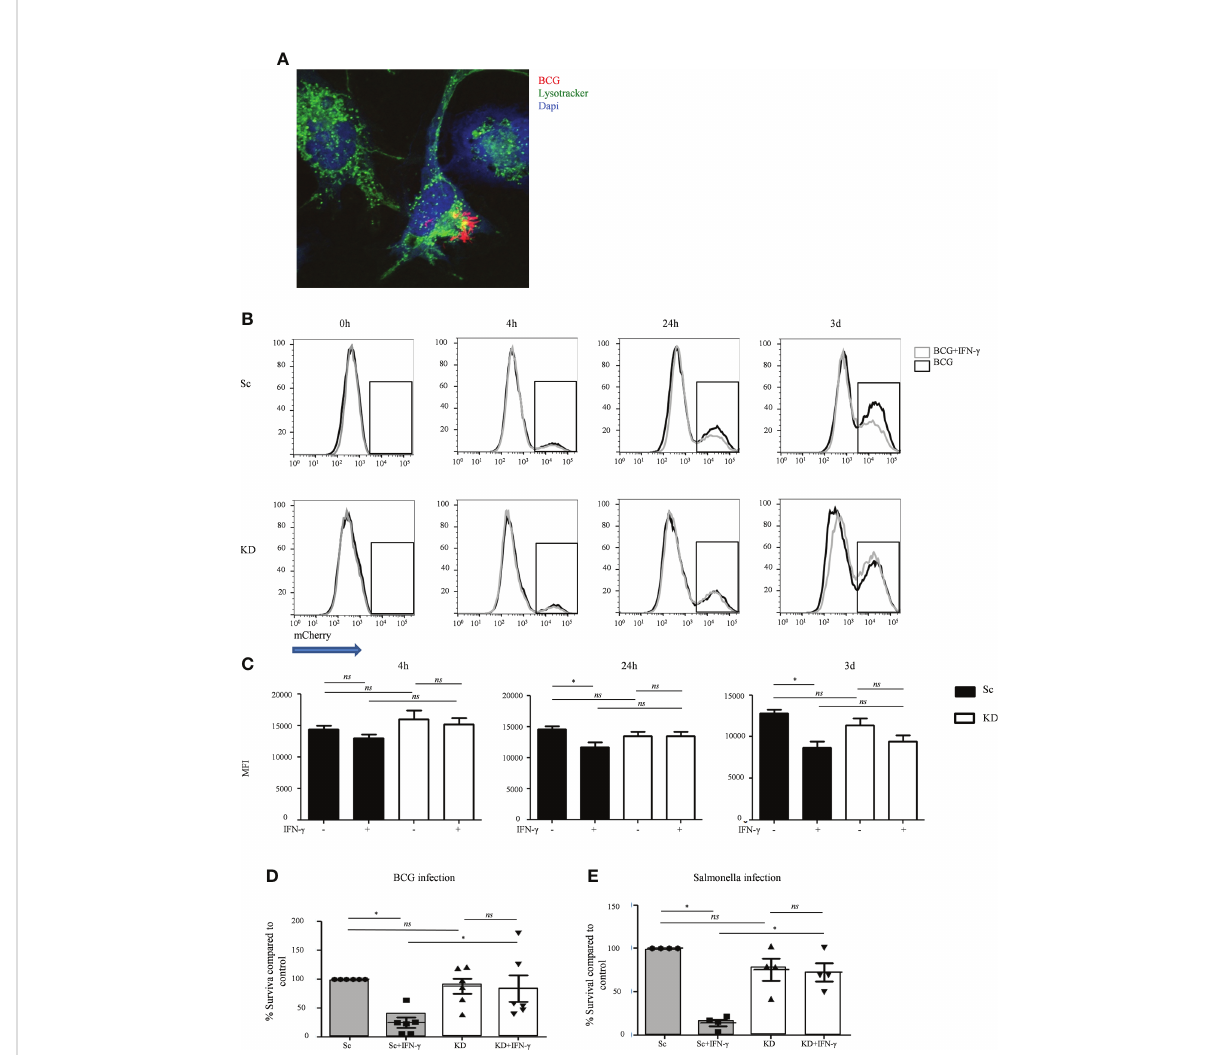
FIGURE 2 JAK1-de fi cient THP-1 cells show increased mycobacterial and Salmonella survival after IFN g stimulation . (A) Internalization of mCherry-BCG by THP-1 cells, unstimulated or stimulated with IFN- g . A is from a representative experiment . (B, C) FC quantitation of mCherry-BCG in THP-1 cells; mCherry fl uorescence was measured in the PE-Texas Red channel. Black line – BCG infected cells, gray line – BCG infected cells + IFN- g stimulation. B displays a representative experiment; C is from fi ve independent experiments. (D, E) Bacterial survival in THP-1 cells infected with BCG or Salmonell a strains, with or without IFN g stimulation. Data is from six and four independent experiments respectively. Two-tailed Mann Whitney test. *P <0.05; NS, not signi fi